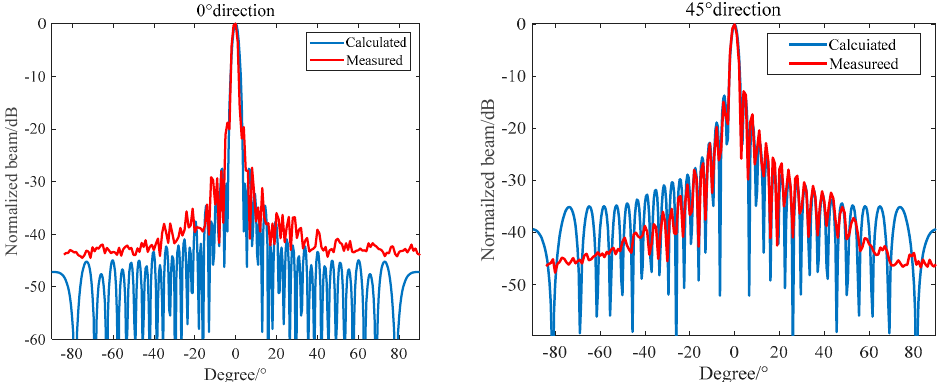
Figure 15. 0° and 45° Directivity of a 390 kHz Octagonal Transmitting Array. Figure 16. Transmitting Voltage Response–Frequency Curve of an Octagonal Transmitting Array.